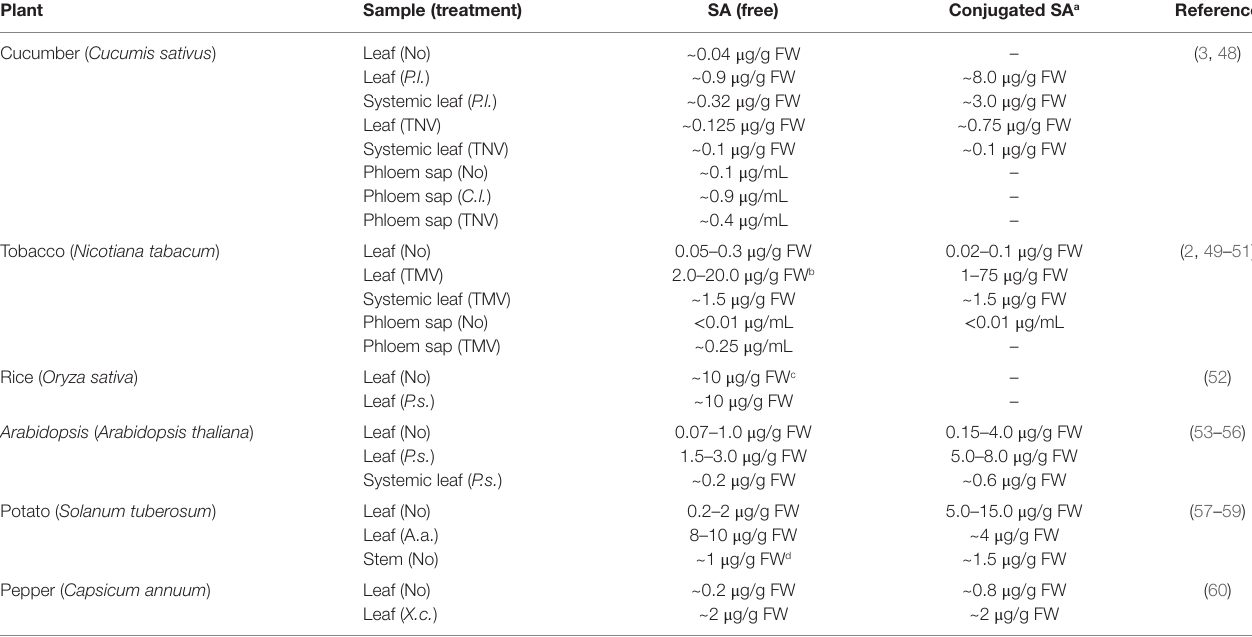
TABLe 3 | endogenous salicylic acid levels in different plants.